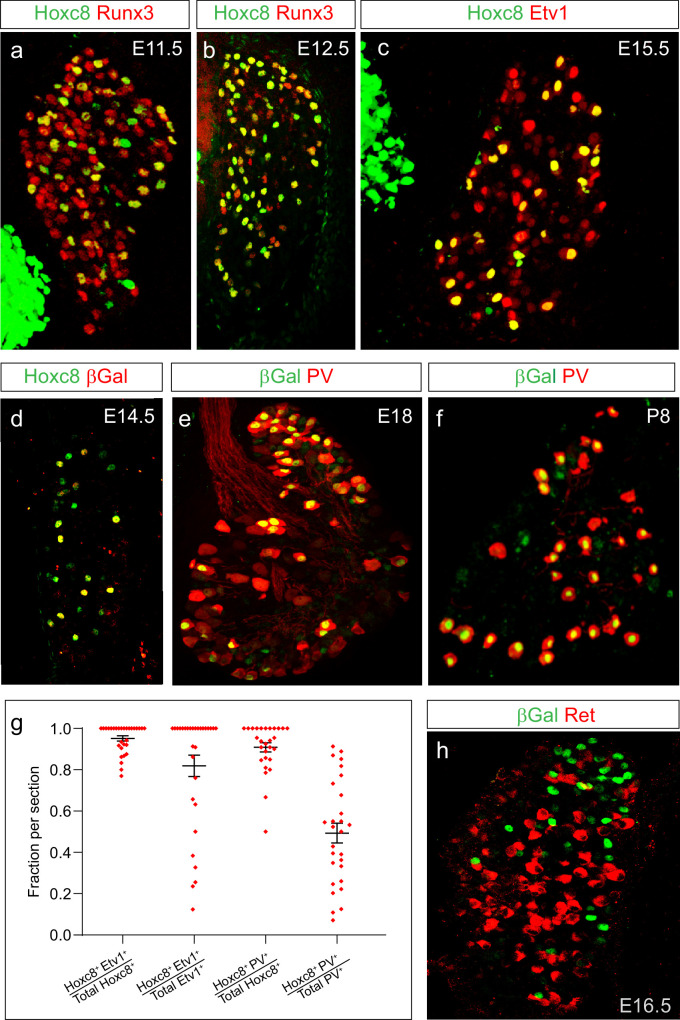
Profile of Hoxc8 in pSNs during sensory-motor circuit development.(a, b) Expression of Hoxc8 with the pSN marker Runx3 at E11.5 (a) and E12.5 (b). (c) Hoxc8 and Etv1 expression in pSNs at E15.5. (d) Colocalization of Hoxc8 and βGal in PLAT::Cre; Hoxc8LacZ-flox/+ mice at E14.5. (e, f) Colocalization of βGal with the pSN marker PV at E18 (e) and P8 (f). (g) Quantification of Hoxc8 with either Etv1 or PV at E14.5. Each data point shows individual sections taken from at least three mice. Hoxc8+Etv1+/total Hoxc8+ cells = 0.95 ± 0.01 (mean ± SEM, N = 30 sections); Hoxc8+Etv1+/total Etv1+ cells = 0.82 ± 0.01 (N = 30 sections); Hoxc8+PV+/total Hoxc8+ cells = 0.91 ± 0.02 (N = 28 sections); Hoxc8+PV+/total PV+ cells = 0.50 ± 0.04 (N = 28 sections). (h) Non-overlapping expression of βGal and Ret, a marker for subpopulations of cutaneous sensory neurons at E16.5. See also Figure 3—figure supplement 1.Figure 3—source data 1.Quanification of marker proteins in sensory neurons.